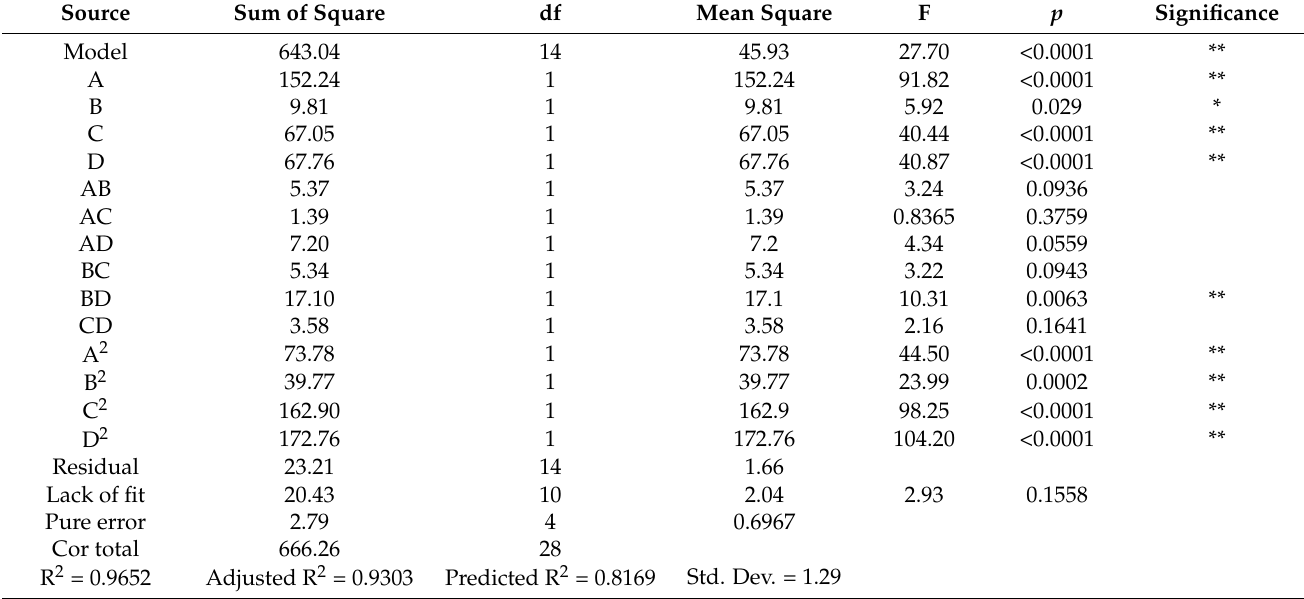
Table 2. Variance analysis of regression